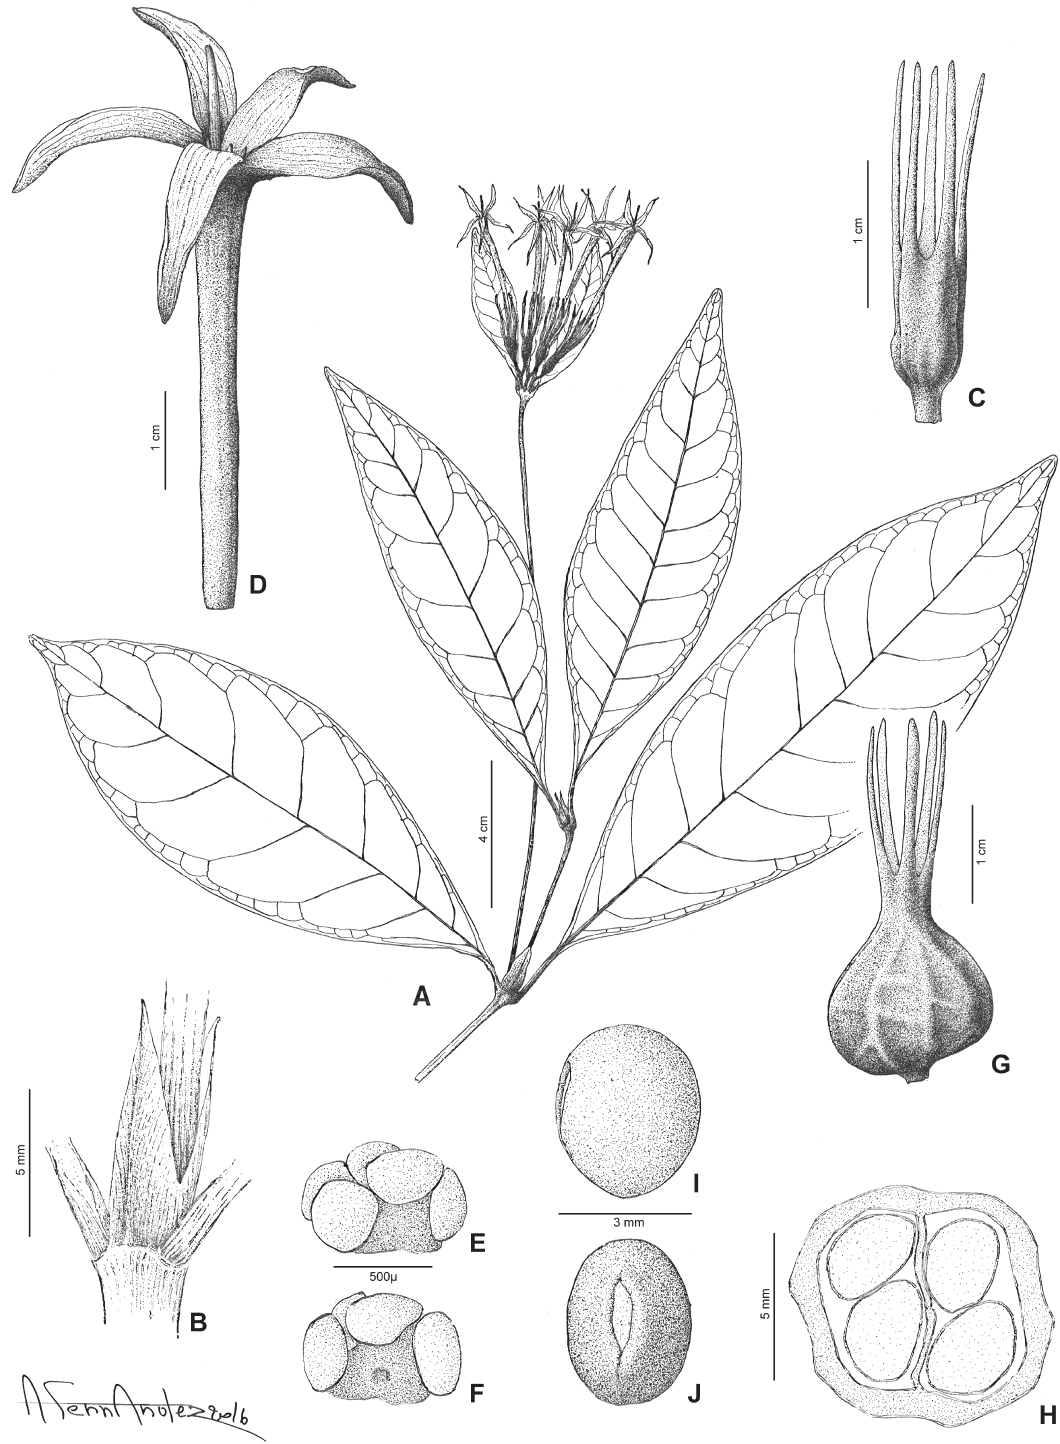
Fig. 3. Homollea longiflora Arènes. A . Flowering branch. B . Stipules. C . Ovary and calyx. D . Corolla, stamens, style and stigma. E . Placenta with ovules, abaxial view. F . Placenta with ovules, adaxial view. G . Fruit. H . Transverse section through fruit. I . Seed, lateral view. J . Seed, adaxial view. Drawn by Mr. A. Fernandez. A, C–D from Saboureau 7 (P); B, H–J from De Block et al. 2341 (BR); E–F from De Block et al. 768 (BR); G from Dorr & Koenders 3017